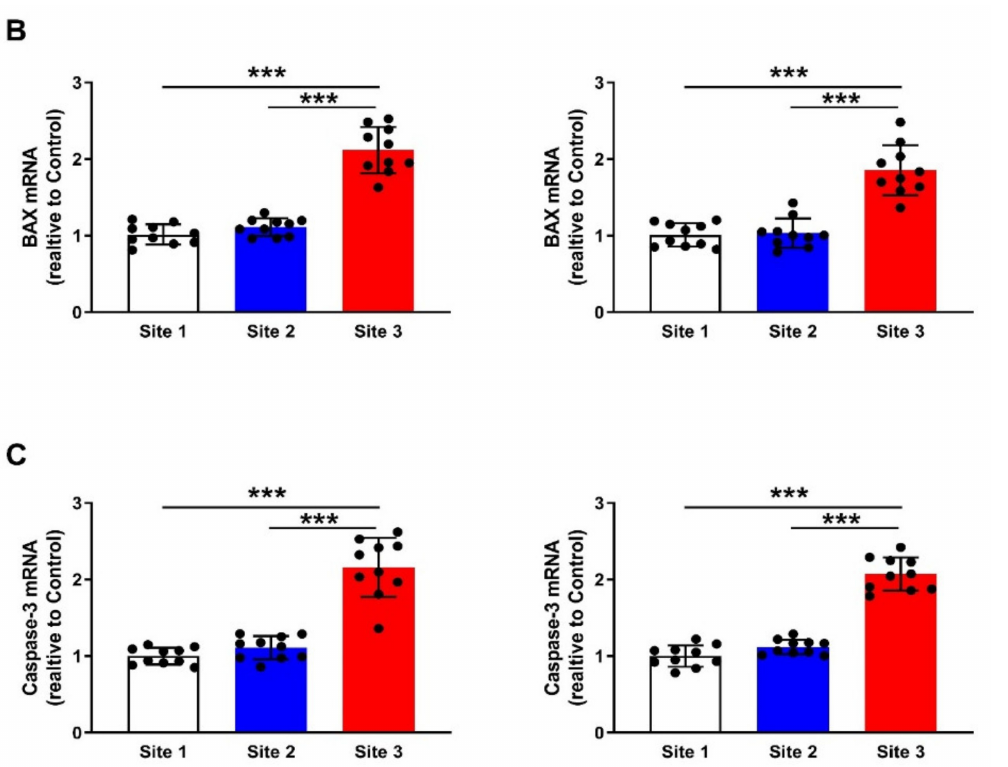
Figure 11. Liver and kidney Bcl-2 ( A ), Bax ( B ), and caspase-3 ( C ) mRNA abundance of camels at the studied sites. Data are mean ± SD ( n = 10). *** p <